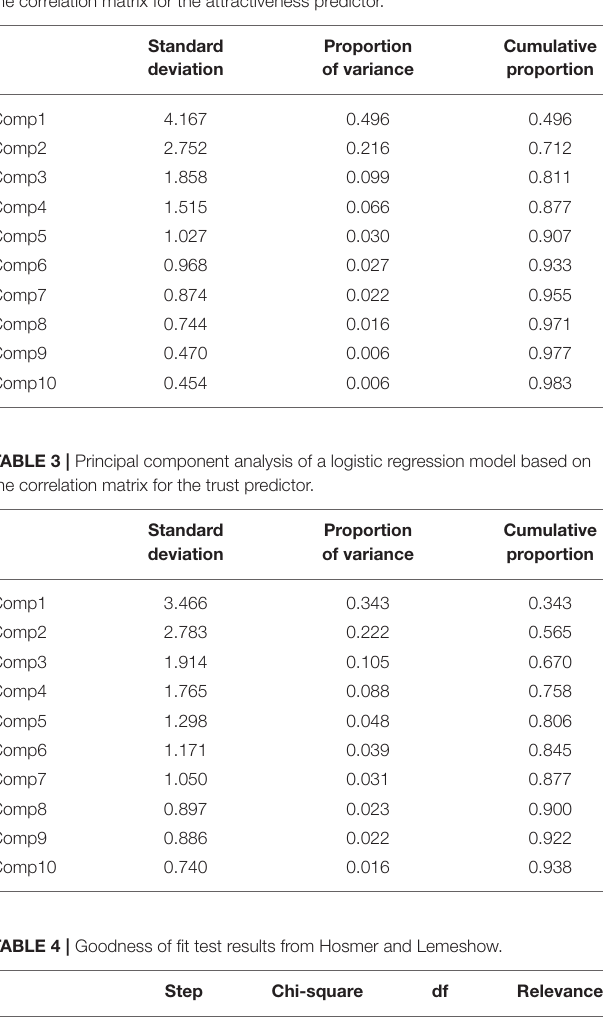
TABLE 2 | Principal component analysis of a logistic regression model based on the correlation matrix for the attractiveness predictor.